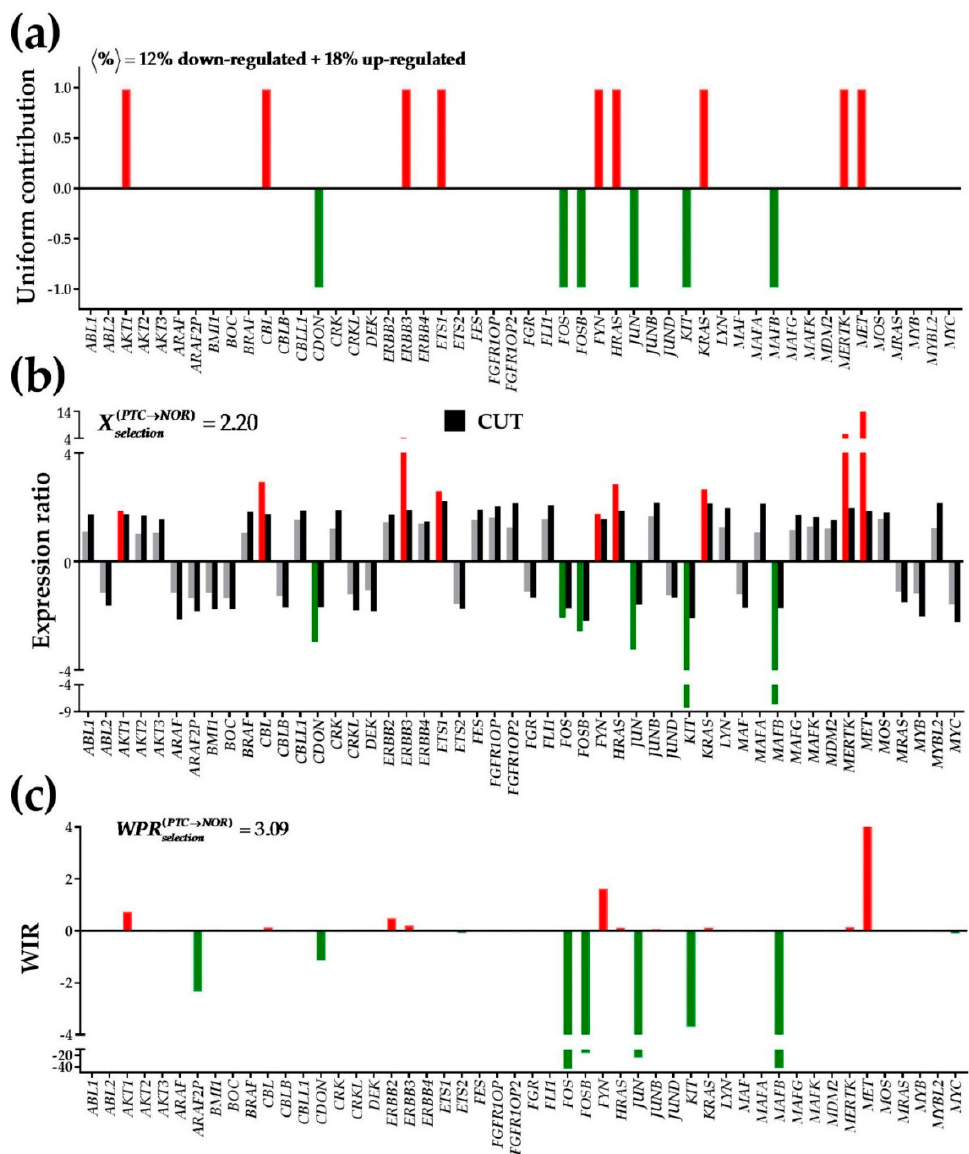
Figure 2. Three ways to consider the contribution of a gene to the pathway regulation. ( a ) uniform; ( b ) by expression ratio; ( c ) as Weighted Individual (gene) Regulation. Red/green/grey columns indicate up-/down-/not regulated genes. Black columns are the fold-change cut-offs (negative for down-regulation). Regulated genes: v-akt murine thymoma viral oncogene homolog 1 ( AKT1 ), Cbl proto-oncogene, E3 ubiquitin protein ligase ( CBL ), cell adhesion associated, oncogene regulated ( CDON ), v-erb-b2 avian erythroblastic leukemia viral oncogene homolog 3 ( ERBB3 ), v-ets avian erythroblastosis virus E26 oncogene homolog 1 ( ETS1 ), homologs of FBJ murine osteosarcoma viral oncogene ( FOS/FOSB ), FYN proto-oncogene, Src family tyrosine kinase ( FYN ), Harvey rat sarcoma viral oncogene homolog ( HRAS ), jun proto-oncogene ( JUN ), Kirsten rat sarcoma viral oncogene homolog ( KRAS ), v-yes-1 Yamaguchi sarcoma viral related oncogene homolog ( LYN ), v-maf avian musculoaponeurotic fibrosarcoma oncogene homolog B ( MAFB ), c-mer proto-oncogene tyrosine kinase ( MERTK ) and met proto-oncogene ( MET ).